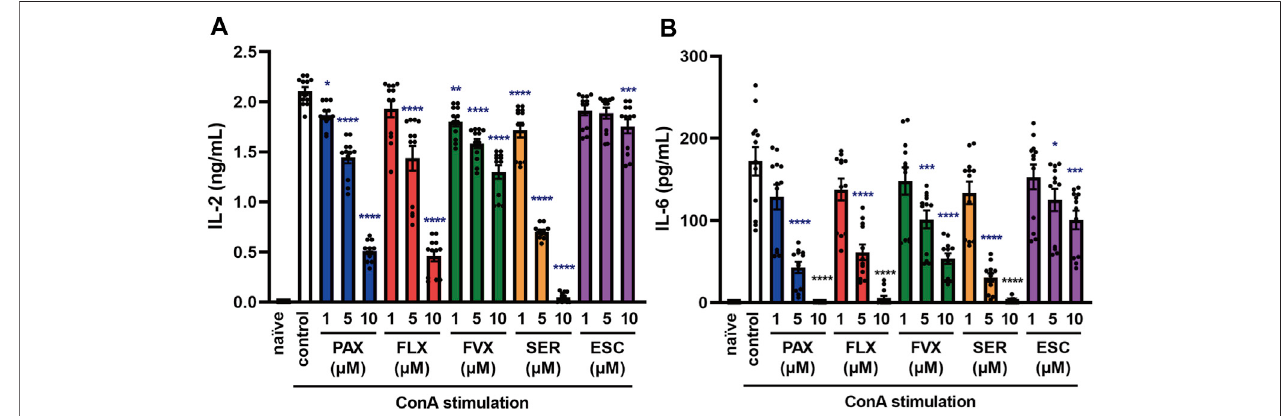
FIGURE 7 | Effects of SSRIs on cytokine production induced by a T cell activator in murine splenic lymphocytes. Splenic lymphocytes of C57BL/6 mice were pre- incubated with each SSRI (1 – 10 µM) for 30 min and then incubated with ConA (5 μ g/ml) for 24 h. IL-2 (A) or IL-6 (B) was measured by means of ELISA. Error bars indicate±SE( n =12,threeindependentexperiments).Statisticalanalysiswasperformedbyone-wayANOVAfollowedbyDunnett ’ stest.Signi fi cantdifferencesbetween control and test groups are indicated by * p < 0.05, ** p < 0.01, *** p < 0.001, **** p < 0.0001. ConA, Concanavalin A; PAX, paroxetine; FLX, fl uoxetine; FVX, fl uvoxamine; SER, sertraline; ESC,